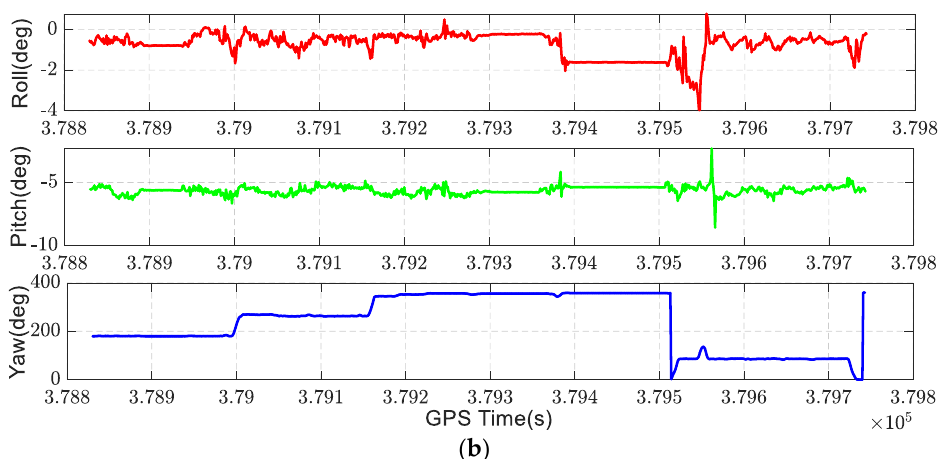
Figure 4. The vehicular speed and attitude in the field test: ( a ) the vehicular speed; and ( b ) the ve-